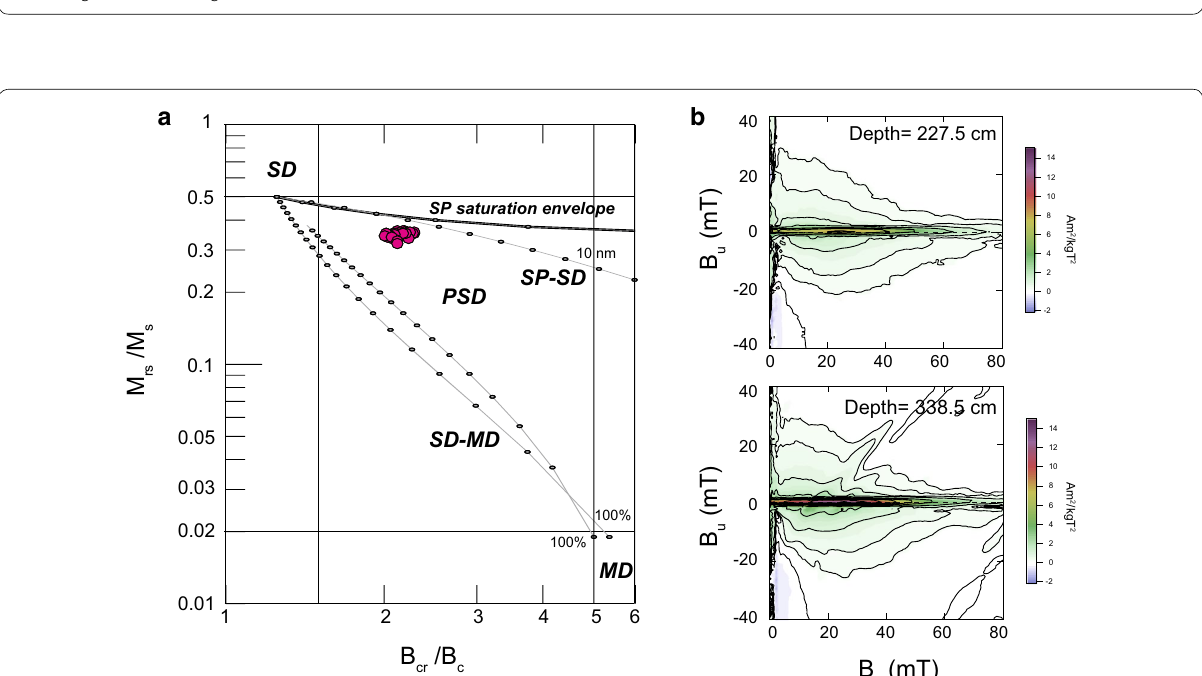
Fig. 4 a Plot of hysteresis ratios (Day plot; Day et al. 1977) and b representative examples of first-order reversal curve (FORC) diagrams. In the Day plot, the single-domain (SD), multi-domain (MD), and superparamagnetic (SP) mixing curves of Dunlop (2002) are shown in gray. B cr , remanent coercivity; B c , coercive force; M r , saturation remanent magnetization; M s , saturation magnetization. FORC diagrams are plotted as B c versus interaction field (